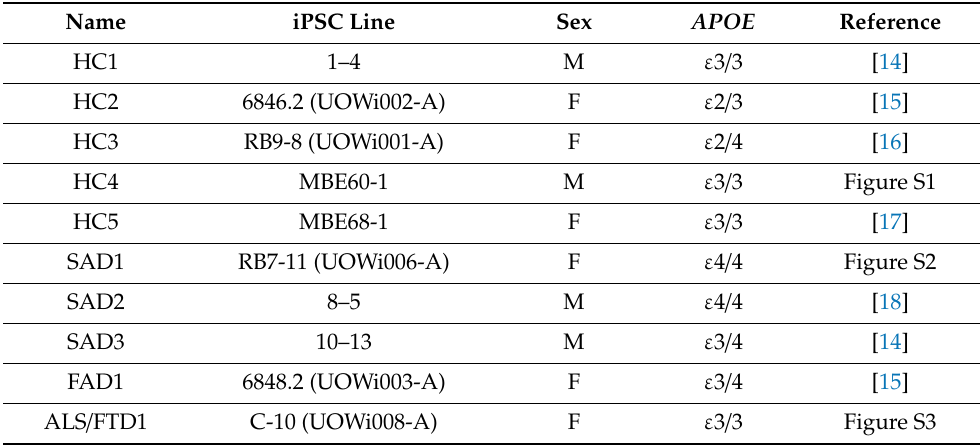
Table 1. List of iPSC lines used. The iPSC lines with the name used, sex and APOE genotype. HC, Healthy Control, SAD, Sporadic Alzheimer’s disease, FAD, Familial Alzheimer’s disease, ALS, Amyotrophic Lateral Sclerosis, FTD, Frontotemporal